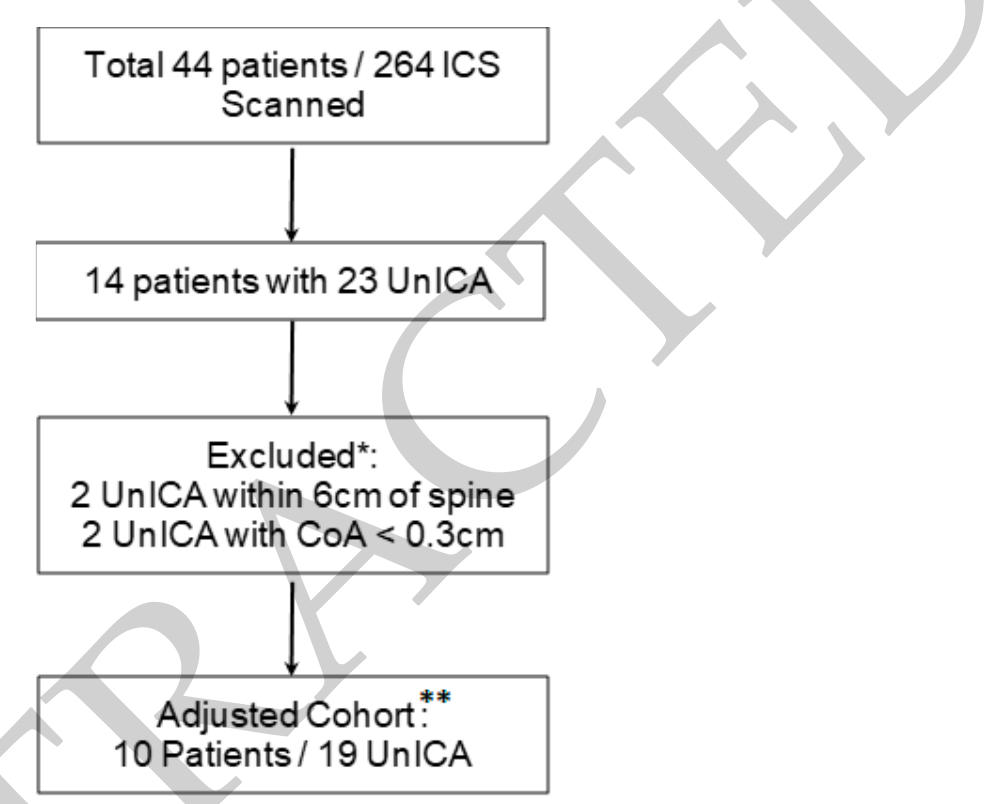
Figure 3. Adjusted Cohort. Legend: ICA: Intercostal Artery, VICA: Vulnerable ICA, CoA: Distance of the inferior border of the ICA to the inferior border of the superior rib, ICS: Intercostal Space. * VICAs were excluded if they were within 6 cm of the spine or located in the rostral 0.3 cm of the ICS. ** Adjusted Cohort was used in final data analysis.